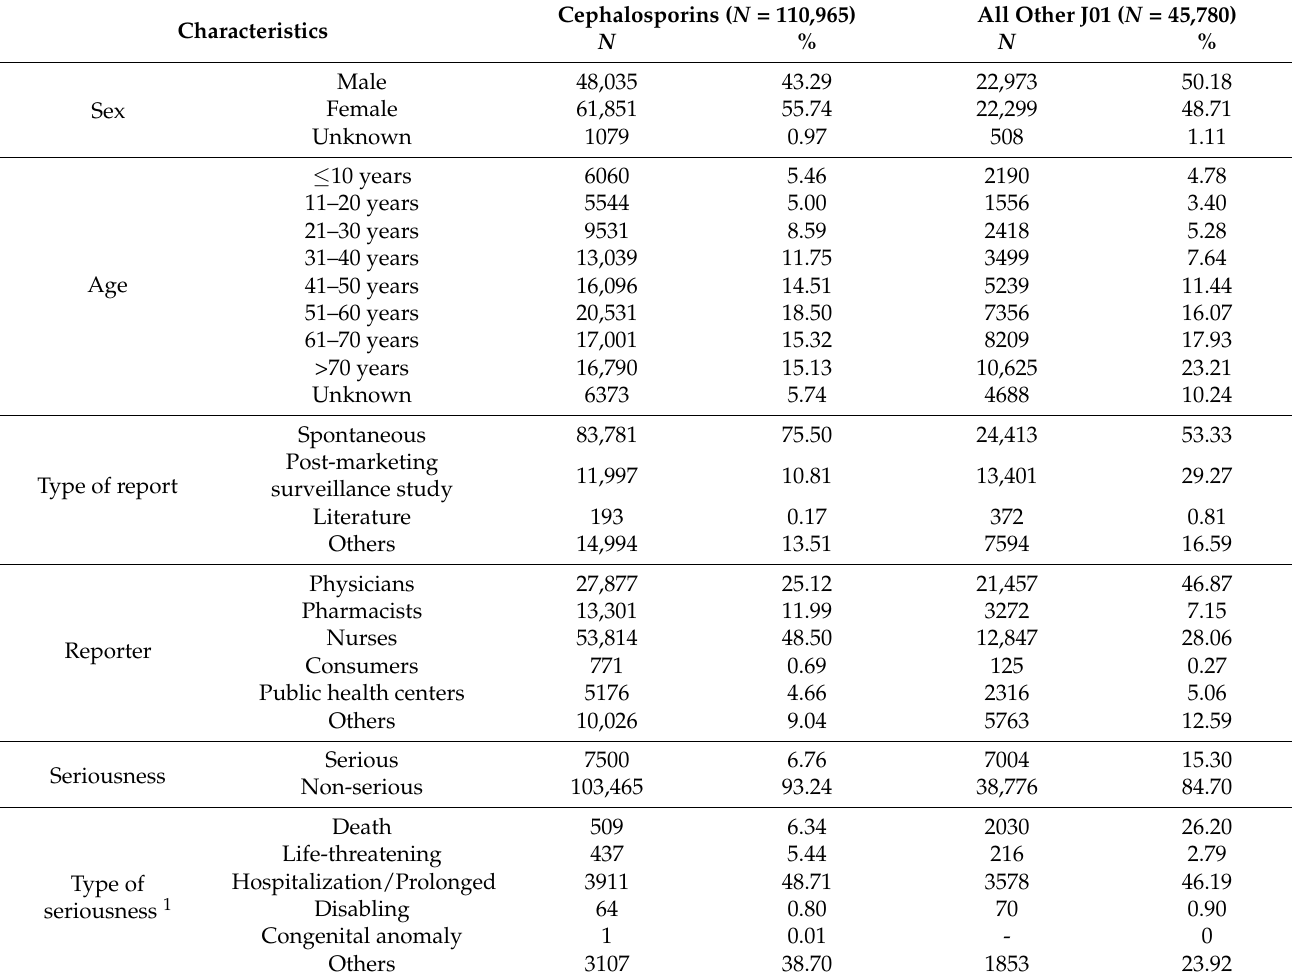
Table 1. Characteristics of AE